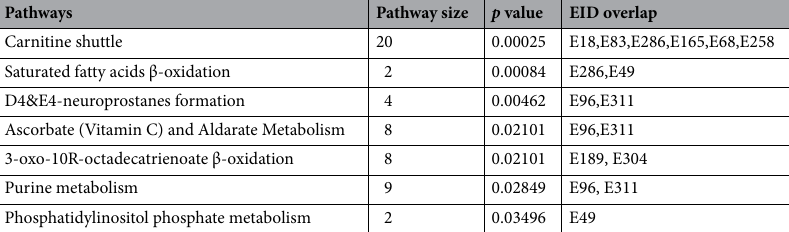
Table 2. Top metabolite pathways associated with significant differences between timepoints. EID , Empirical ID; Pathway size , number of features associated with each pathway; EID overlap , features within the pathway which are significant.